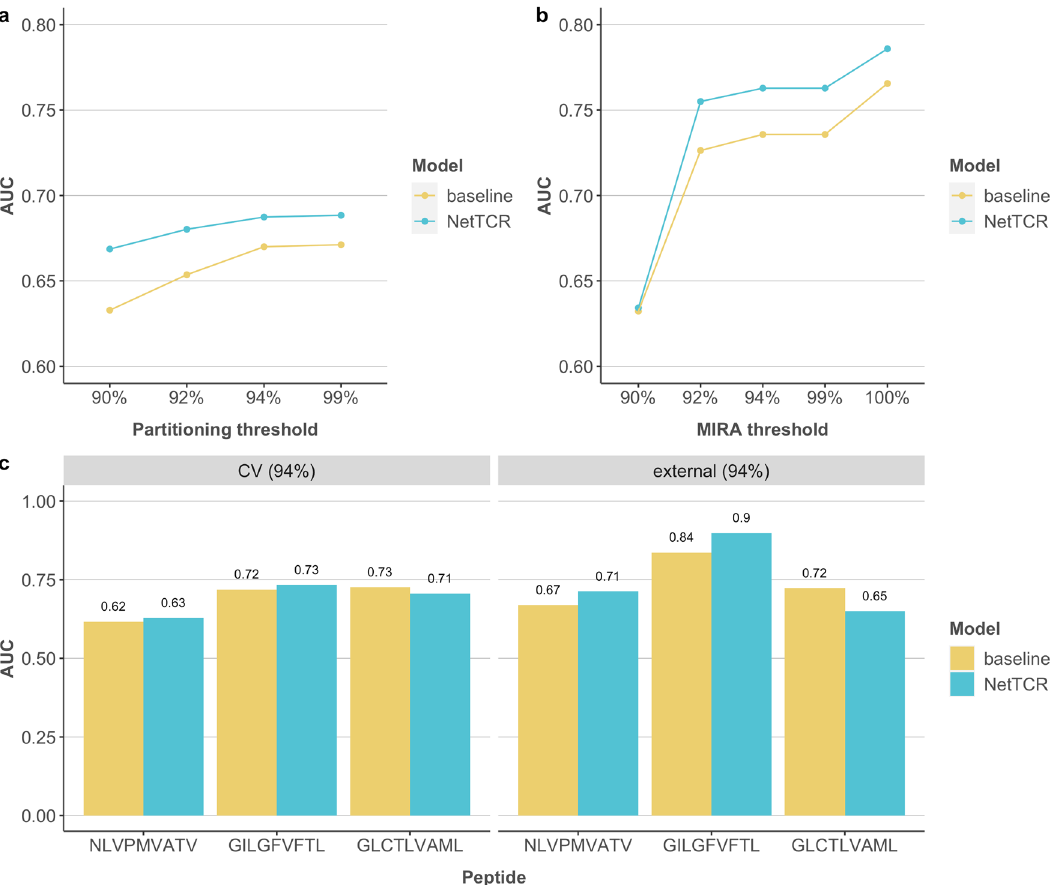
Fig. 1 Performance of models trained on CDR3 β data alone. a Overall AUCs evaluated via cross-validation of different training data-partitioning thresholds for the baseline model and NetTCR. Partitioning thresholds are indicated in percent on the x-axis. b Overall AUCs evaluated on the MIRA sets at different thresholds (shown on the x-axis) using the model trained on the 94% similarity-partitioned data. The MIRA threshold represents the degree of separation between the training set and the MIRA set. c Peptide-speci fi c AUCs for 94% partitioned cross-validation (CV) and external evaluation with a similarity threshold of 94%, colored by